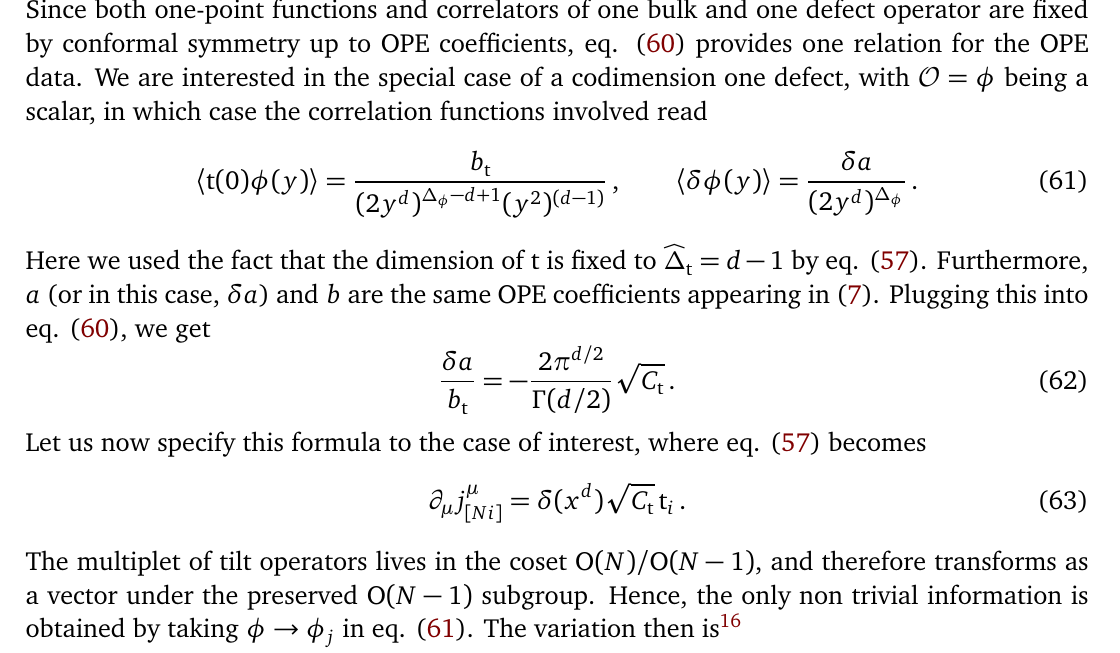
Figure 12: Configuration of the defect operator which yields the Ward identities O